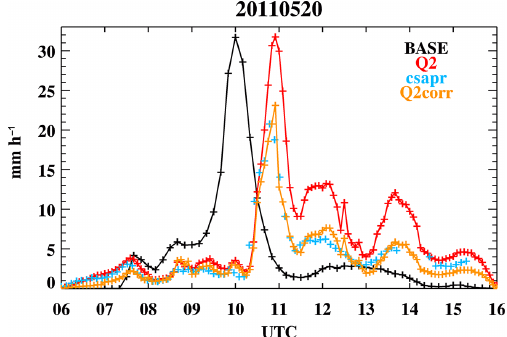
Figure 8. Time series of precipitation from the BASE simulation, National Mosaic and Multi-Sensor Quantitative Precipitation Es- timate (Q2), C-SAPR, and gauge-corrected Q2 averaged over the region sampled by aircraft ∼ 13:54–14:54UTC indicated by a red rectangle in Fig.